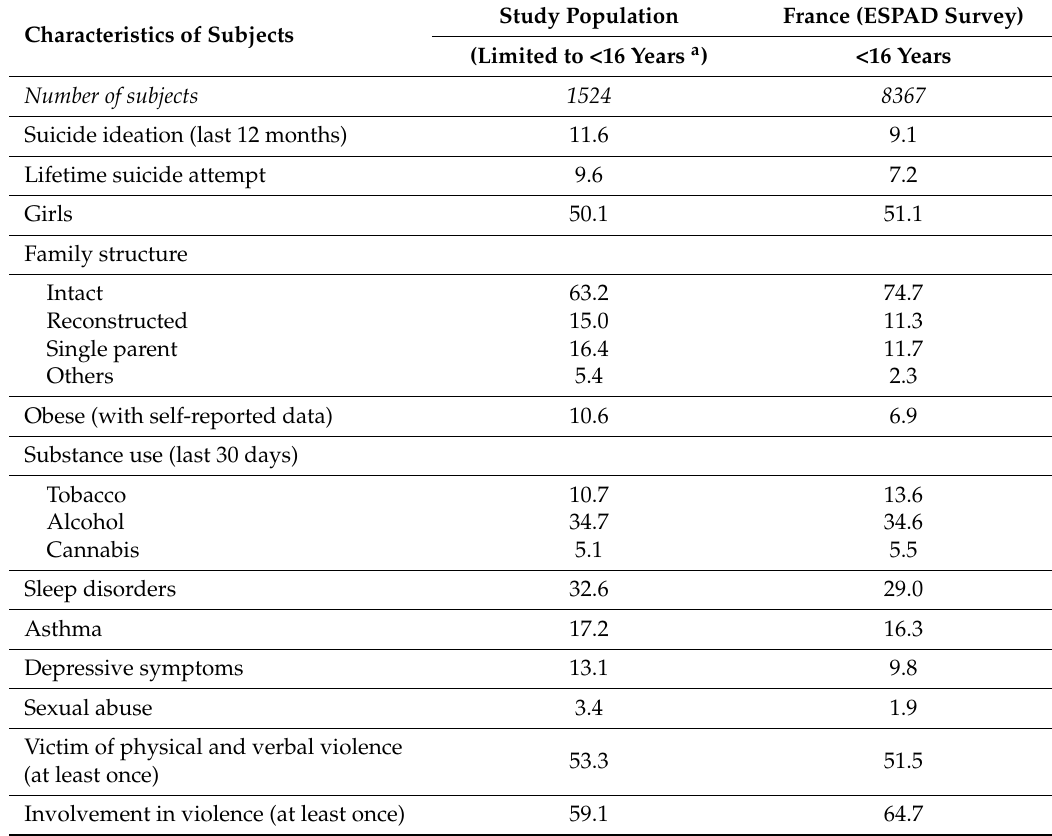
Table 1. Comparison between the study population and France [2,12,37]: